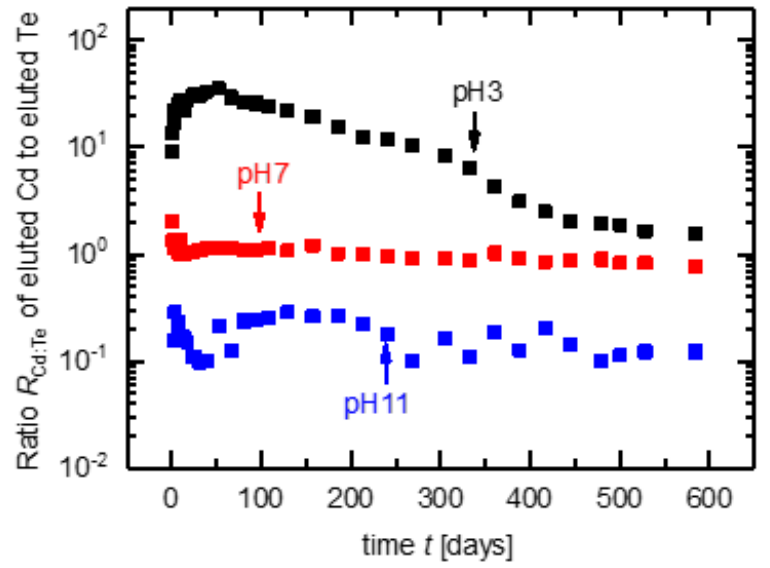
Figure 7. Ratio R Cd : Te of dissolved Cd to dissolved Te from leaching CdTe module pieces in solutions with pH 3, pH 7, and pH